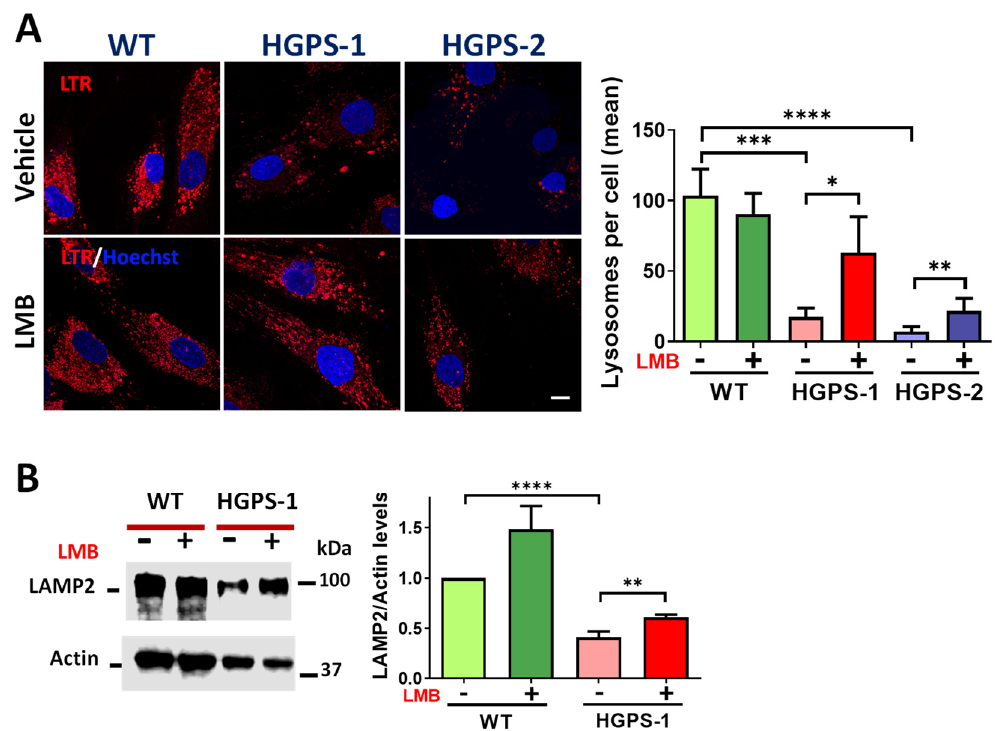
Figure 8. LMB-mediated inhibition of CRM1 improves the lysosomal content of HGPS cells. ( A ) WT and HGPS-1 and HGPS-2 fibroblasts grown on coverslips were treated with LMB or the vehicle alone for 3 days and then stained with Lysotracker and Hoechst to visualize lysosomes and nuclei, respectively. Right . The number of lysosomes per cell was quantified and graphed (n = 50 cells per condition). Data denote significant differences (unpaired t test; * p < 0.05; ** p < 0.01; *** p < 0.001; **** p < 0.0001). ( B ) Fibroblast lysates were evaluated by Western blotting using specific antibodies for LAMP2 and actin (loading control). Right. The level of LAMP2 was assessed. Data correspond to the mean +/ − SD of three separate experiments, with p values denoting significant differences (unpaired t test; ** p < 0.01; **** p < 0.0001); ns, not significant.